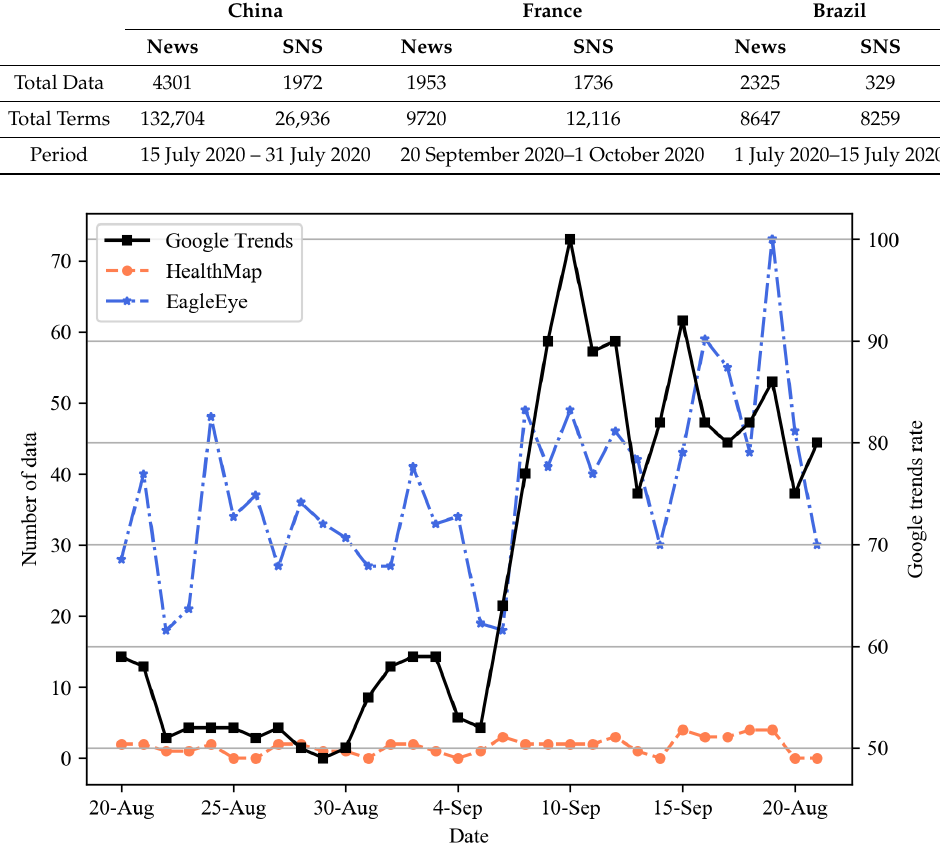
Figure 7. Daily time-series number of COVID-19-related data for